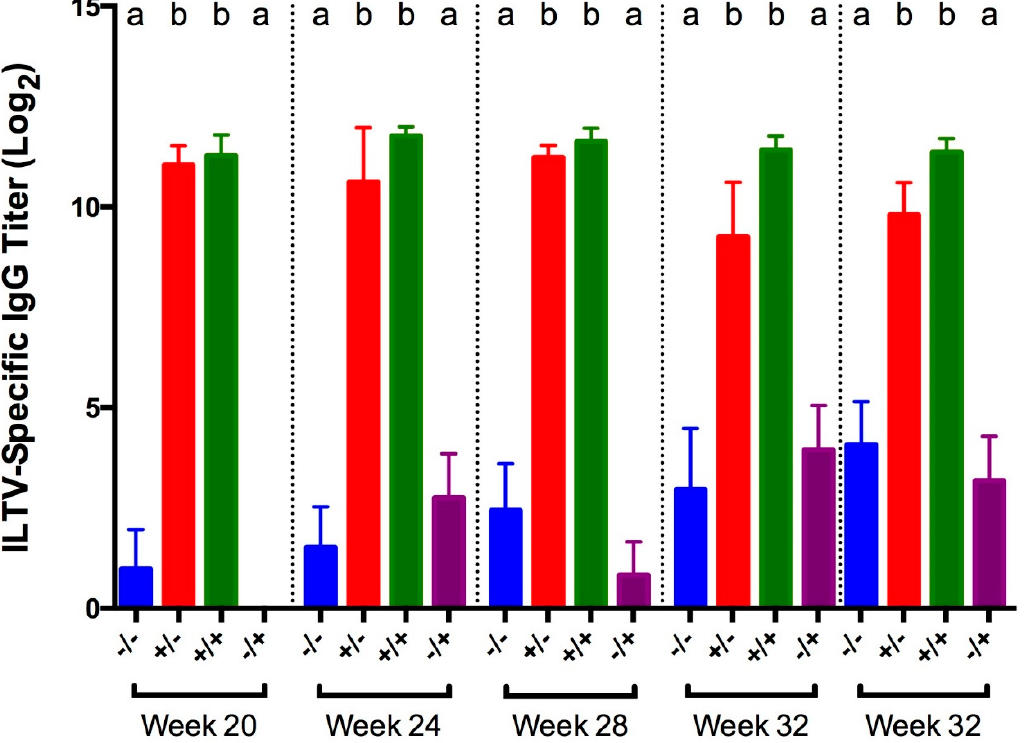
Figure 6. ILTV-specific IgG titers in serum collected 5 days post-challenge with ILTV strain 63140 for different groups of birds challenged at 20, 24, 28, 32, and 36 WOA. Letters (a–b) indicate significant differences among vaccine and challenge groups for each week ( p < 0.05). − / − = non-vaccinated/non-challenged, +/ − = vaccinated/non-challenged, +/+ = vaccinated/challenged, − /+ = non-vaccinated/challenged.